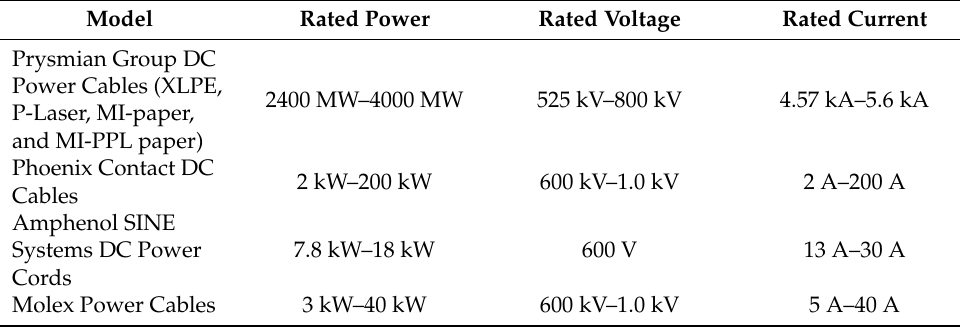
Table 2. Models and ratings of some DC